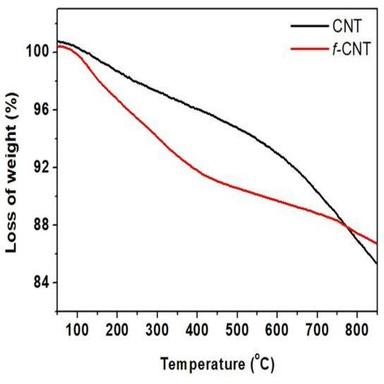
TGA curves of neat and functionalized CNTs.